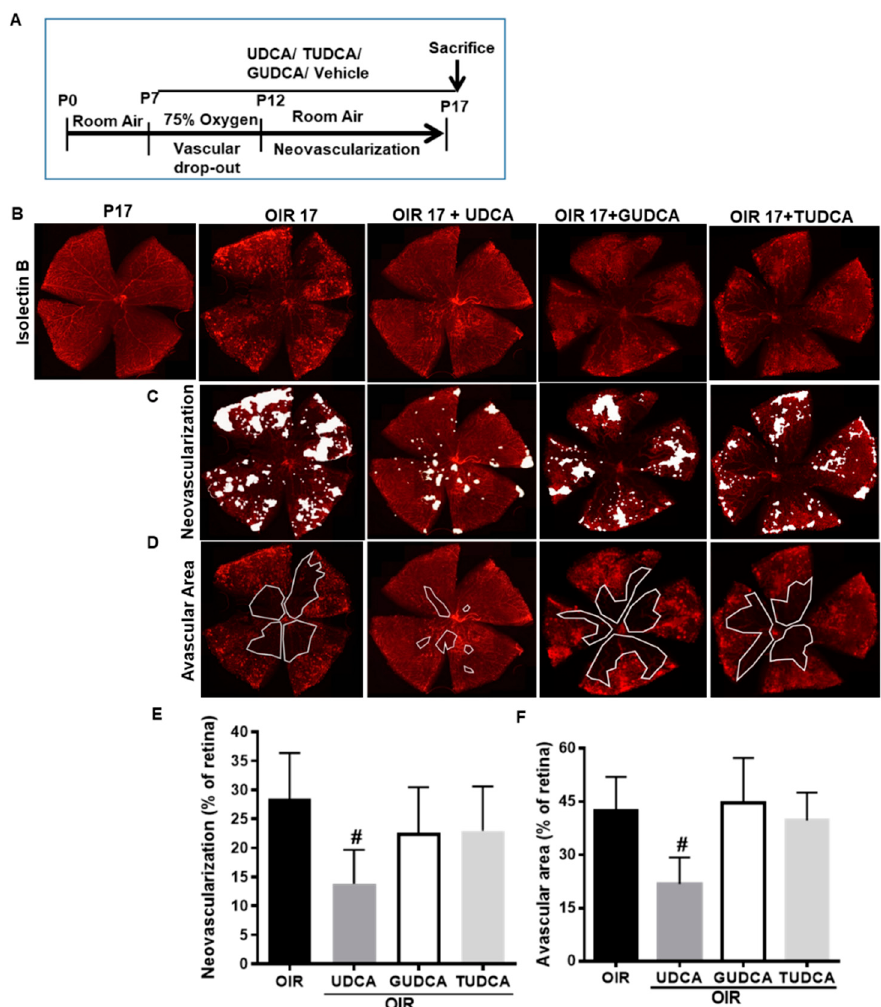
Figure 1. Effects of UDCA, TUDCA, and GUDCA treatment from P7 to P17 on pathological retinal neovascularization. ( A ) Overview of mouse OIR experimental model and different bile acids (BA) treatment paradigms. UDCA, TUDCA, and GUDCA (50 mg/kg) were administered by daily intraperitoneal injection from postnatal (P) days 7 to 17. All mice were euthanized at P17 and retinal flat mounts were stained with isolectin B4. ( B ) Representative retinal flat mounts from P17, OIR 17, and OIR17 treated with different BA (OIR 17 + UDCA, OIR 17 + TUDCA, and OIR17 + GUDCA). ( C ) The neovascular areas are indicated with white spots and the ( D ) area of avascular zones is highlighted with a white continuous line. ( E–F ) Histograms representing the results of morphometric analysis of retinal flat mounts measuring ( E ) area of neovascular tufts and ( F ) avascular areas. Values are mean ± S.D. ( n = 6 retinas per group). # p < 0.05 vs. OIR. UDCA: ursodeoxycholic acid; TUDCA: